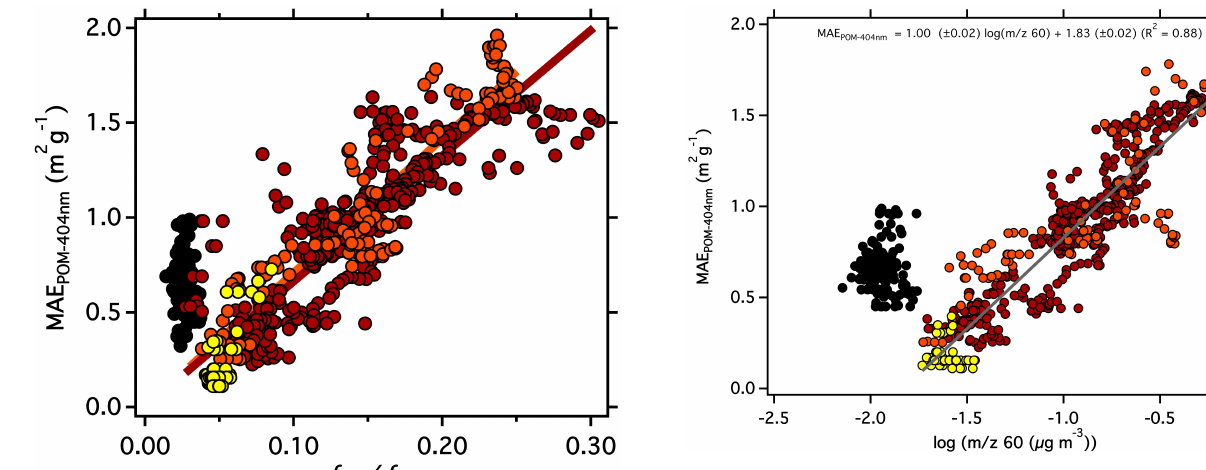
Fig. 5. Mass absorption efficiency (MAE, at 404nm) versus mass of m/z 60. The color-coding shows the BB plumes sampled (Lack et al., 2012b). Linear fit to both red and orange data periods also shown as solid